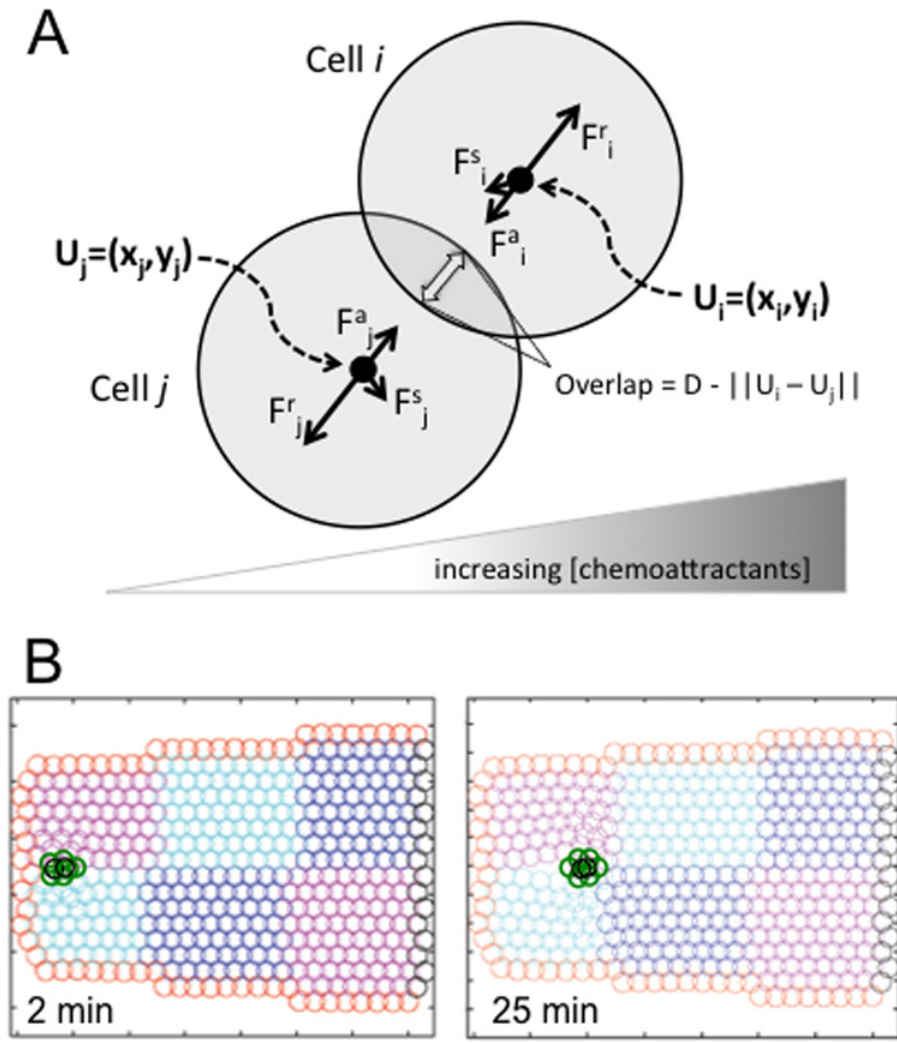
Fig 2. A force-based biophysical model comprised of discrete Individual Math Cells. (a) The forces between two adjacent IMCs, i and j . The repulsive force acts to separate contacting IMCs, while the adhesive force acts to attract IMC i and j when they are within an ε distance from one another. If one of the IMCs is migratory, it produces a migratory force perpendicular to the axis of interaction due to signal from the gradient of chemoattractants. There is stochastic fluctuation in the position of each IMC. These forces balance and produce overlap between i and j of D − k U i − U j k 2 , where D is the diameter of the IMC. Adhesion force between IMCs creates the integrity of a large single cell or cluster of individual cells with special affinity. The central cluster with a higher adhesion coefficient is closer or more tightly bound to one another than to outside cells, or than outside cells are to one another. (b) The IMC- based domain and simulation in two dimensions. The anterior half of the egg chamber is represented by IMCs with different properties. The epithelial cells are equated to IMCs (red), while the nurse cells are formed from many IMCs (blue, pink, and cyan). The line of black IMCs to the right is the surface of the oocyte at the mid-point of the whole egg chamber. The migratory cluster is formed of tightly bound border cells (green) and polar cells (black). 25 minutes into a 2D simulation, the model shows penetration of the cluster into the egg chamber between malleable nurse cells.